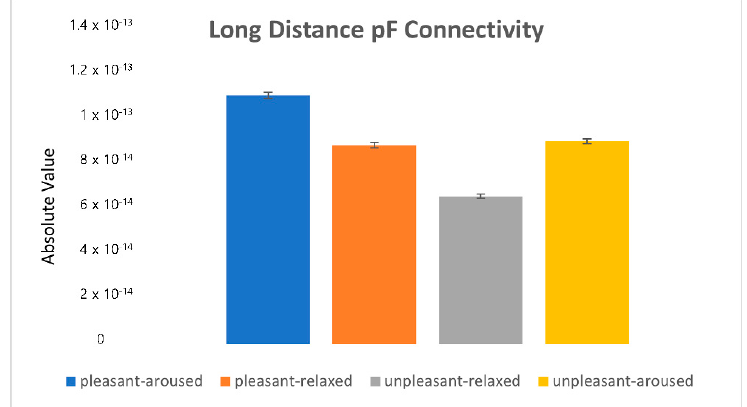
Figure 18. The absolute value in the long-distance prefrontal connectivity.